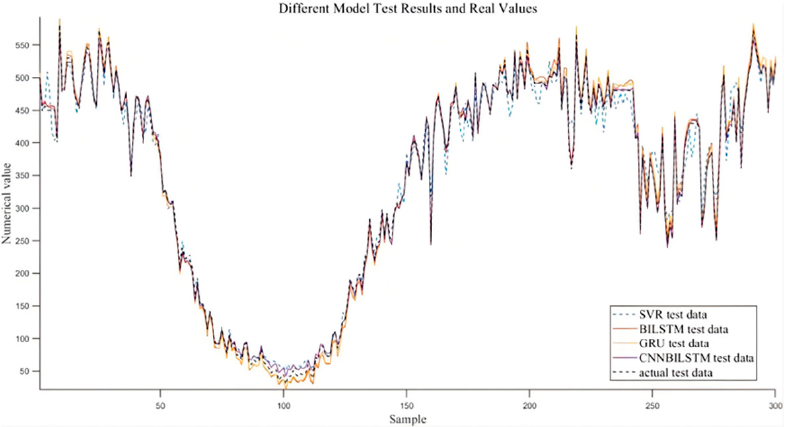
Figure 8. 5-minute forecast result graph.